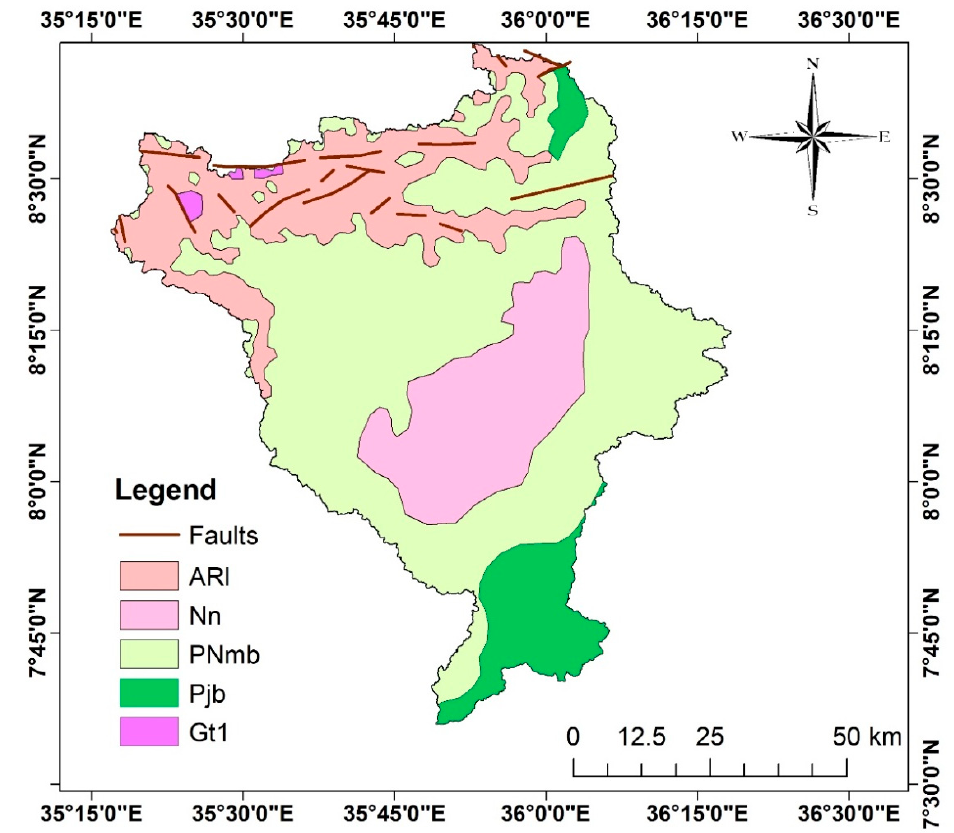
Figure 3. Geological map of the watershed (modified from GSE, 2005; 1: 250,000).